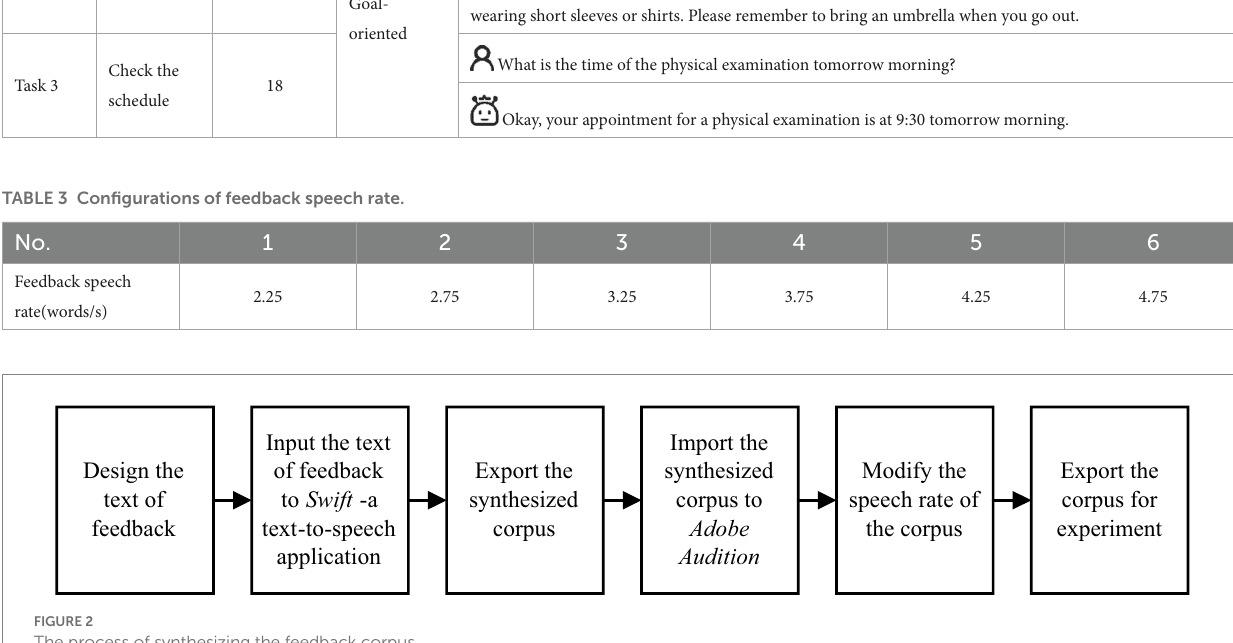
FIGURE 2 The process of synthesizing the feedback